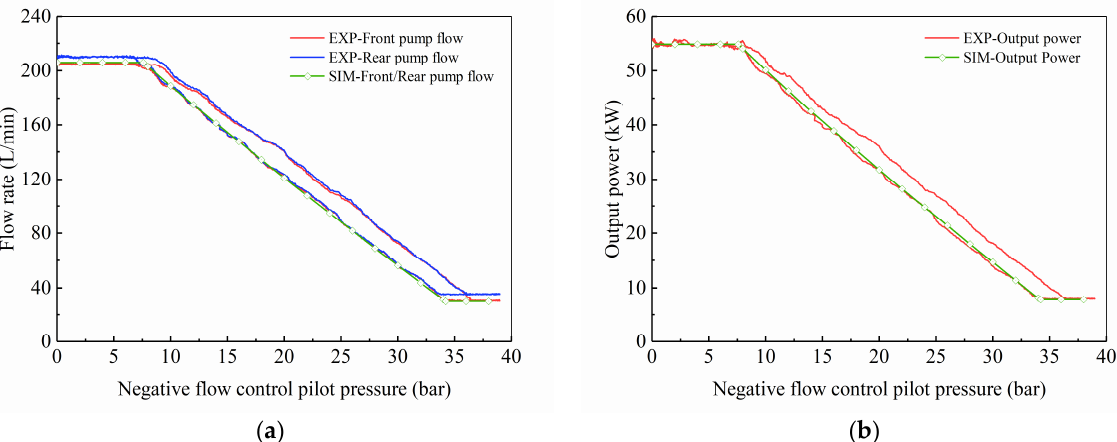
Figure 14. Characteristics curves of the double-compound axial piston pump under working condi- tion 3: ( a ) outlet flow; ( b ) output power.